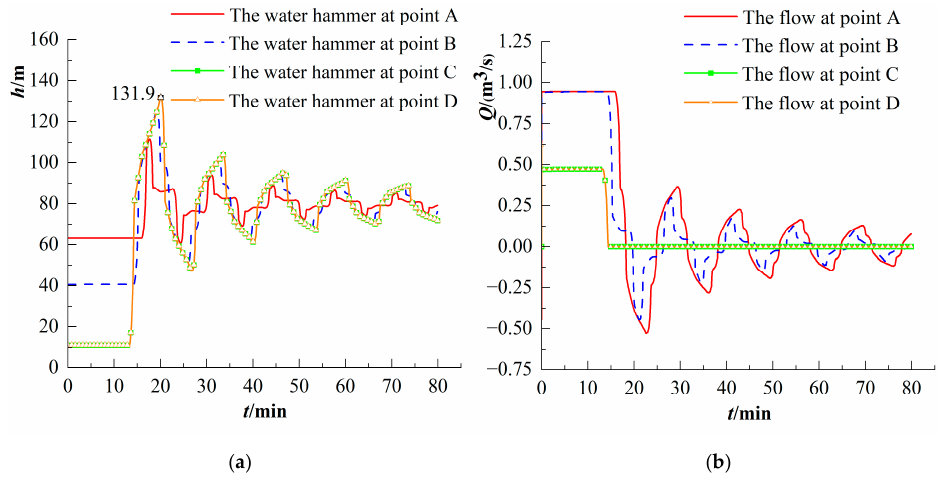
Figure 9. The flow and water hammer wave variations at different locations when the end valves C and D are closed. ( a ) The water hammer changes with time at different positions. ( b ) Flow at different locations varies with